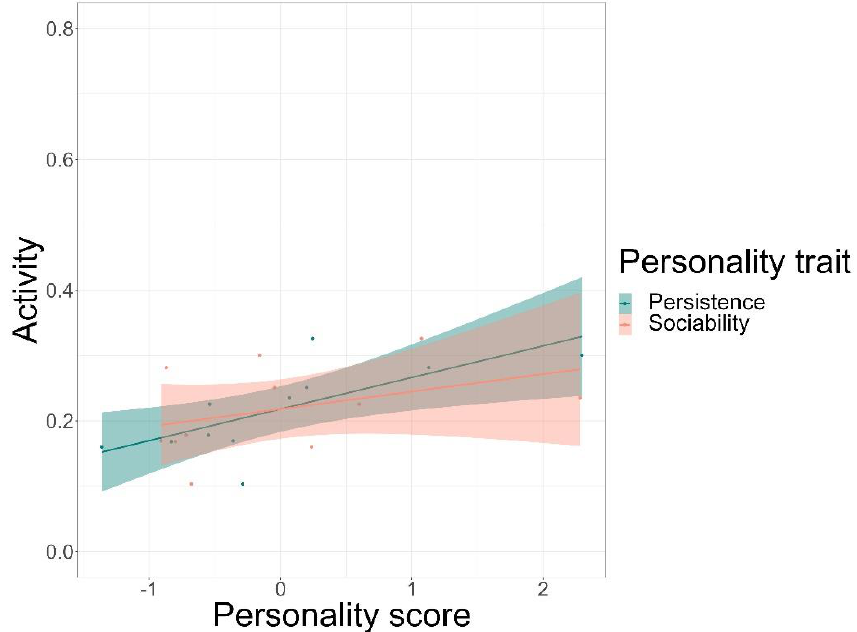
Figure 4. Time spent being active in percentages and its relation to the personality scores of the traits of persistence and sociability. The solid line is a trend line surrounded by the 95% confidence interval.